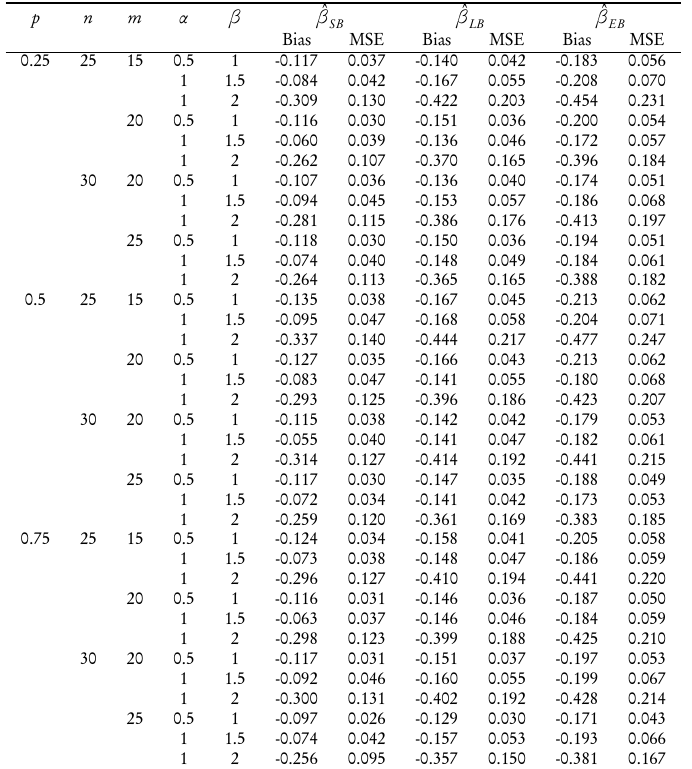
Bias and MSE of the Bayes estimates under squared error loss function ˆ β and entropy loss function ˆ β